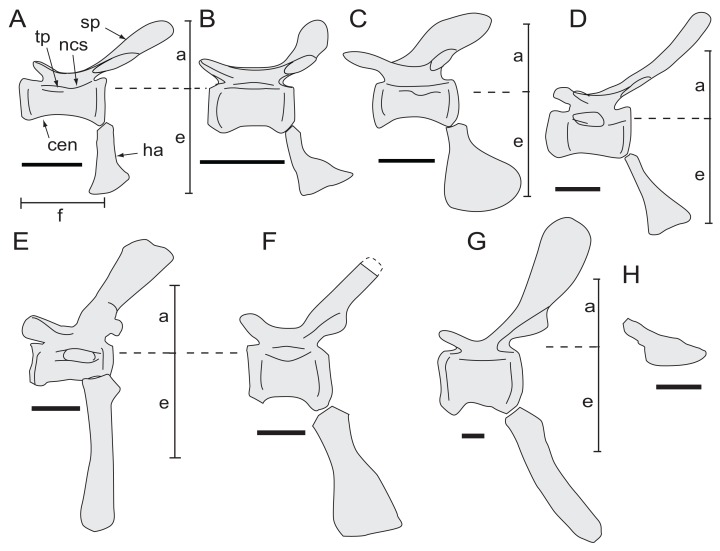
Middle caudal vertebral profiles for selected ornithopods in left lateral view.A–G: (A) Diluvicursor pickeringi gen. et sp. nov. holotype (NMV P221080), ∼Ca 14; (B) NMV P185992/NMV P185993, ∼Ca 14; (C) Gasparinisaura cincosaltensis, anterior-most posterior caudal (MUCPv-212, Coria & Salgado, 1996, fig. 4); (D) Valdosaurus canaliculatus, Ca 16 (Barrett, 2016, noting Ca 14 is transitional); (E) Hypsilophodon foxii, ∼Ca 13 (MNHUK R196, based on Hulke, 1882, pl. 74, fig. 13; following vertebral positions reported in Galton, 1974, figs. 28–29); (F) Haya griva, Ca 13 (following Makovicky et al., 2011, fig. 3, noting that caudal ribs persist along the entire vertebral series); (G) Thescelosaurus sp., Ca 13 (Sternberg, 1940, fig. 17). (H) Haemal process profile in NMV P186047, ∼Ca 14. Vertebral scales normalised for centrum length (‘f’) at Ca 14 on NMV P221080, with distances ‘a’ and ‘e’ based on the same vertebra, where ‘a’ equals neural arch height and ‘e’ equals vertebral height from the neurocentral suture to the ventral tip of the haemal process (i.e. ‘a’ plus ‘e’ equals total vertebral height, ‘c;’ Fig. 13). Abbreviations: cen, centrum; ha, haemal arch/process; ncs, neurocentral suture; sp, spinal process; tp, transverse process. Scale bars equal 10 mm.